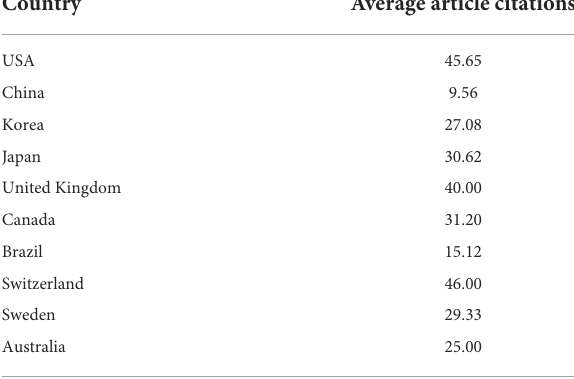
TABLE 2 Average article citations for major participating countries.